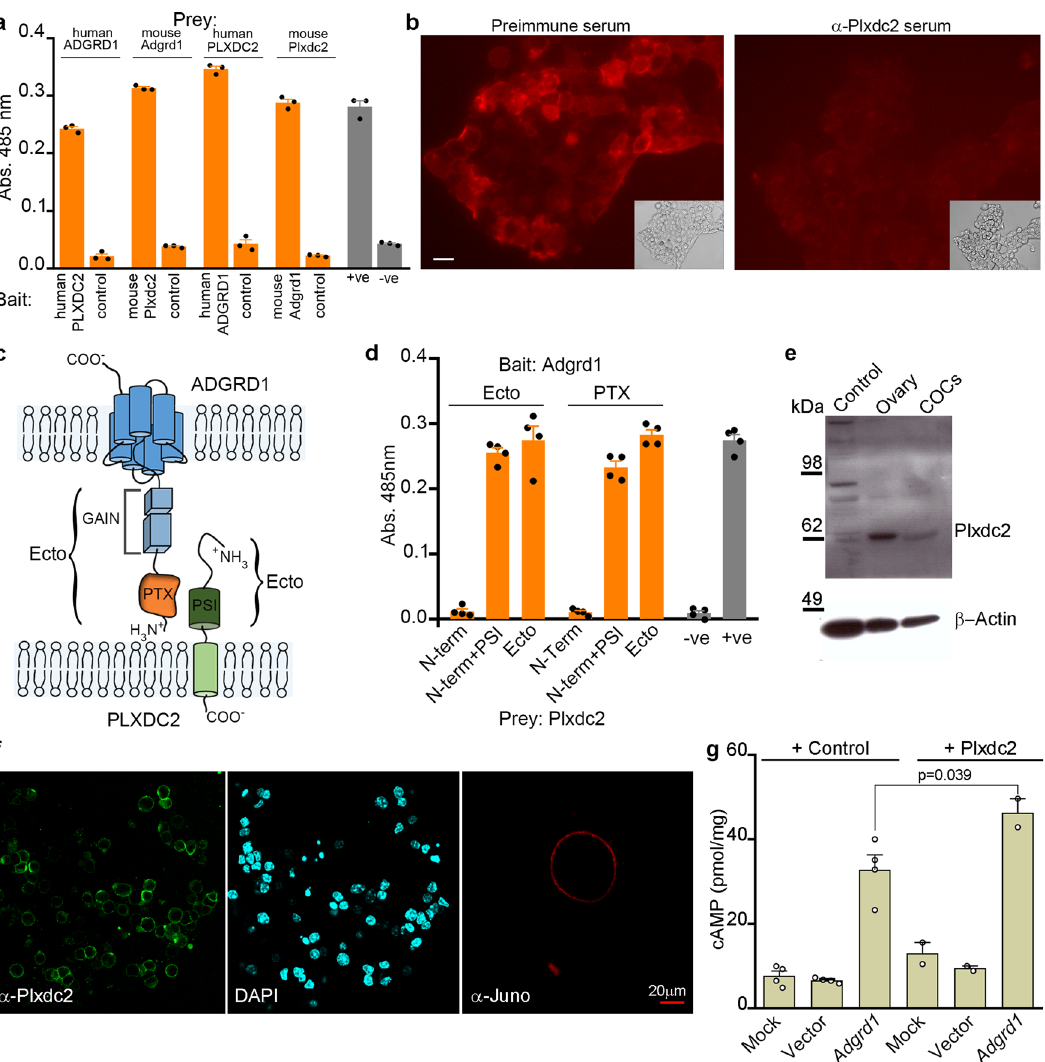
Fig. 5 Plxdc2 is an activating ligand for Adgrd1 and expressed on cumulus cells. a Direct interactions between human and mouse ADGRD1 and PLXDC2 ectodomains in both bait-prey orientations using the AVEXIS assay ( n = 3 independent replicates). b Adgrd1 ectodomain probe bound Plxdc2 -transfected cells (left panel) and was blocked by preincubation with Plxdc2 antiserum (right). Scale bar represents 10 μ m. c Schematic of ADGRD1 and PLXDC2 domain organisation. d Domain truncations demonstrate that the pentraxin (PTX) domain of Adgrd1 and PSI domain of Plxdc2 are suf fi cient for binding ( n = 4 independent replicates). e Western blotting and immuno fl uorescence f demonstrates that Plxdc2 is expressed on the plasma membrane of cumulus cells. HEK293T cells were used as negative control in e , anti-Juno shows the localisation of the oocyte in f . g The overexpression of Adgrd1 induces a signi fi cant increase of intracellular cAMP compared to non-transfected cells (mock) and to cells transfected with a plasmid encoding GFP (vector). The Plxdc2 ectodomain induces a signi fi cant increase of cAMP levels in Adgrd1 -expressing cells only. ( n = 2 independent experiments). Bars in a , d , and g represent mean ±